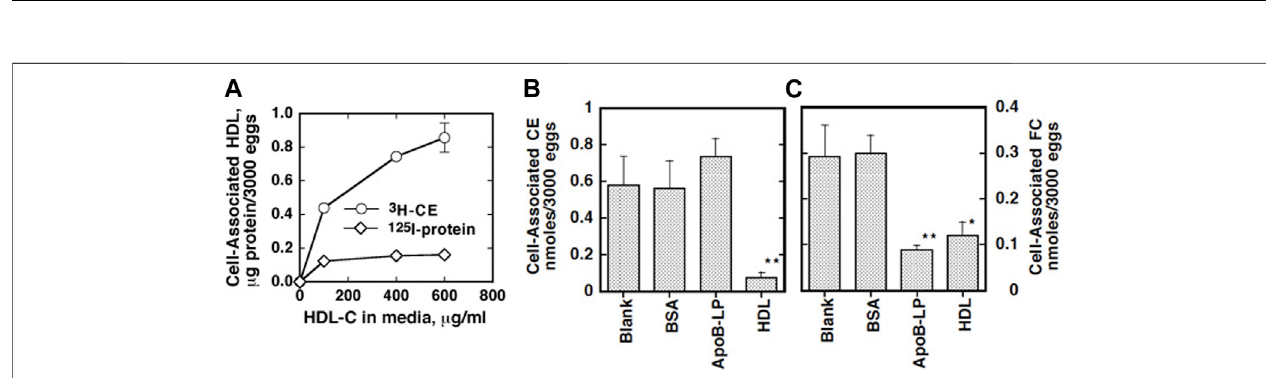
FIGURE 2 | Speci fi c cholesterol uptake from lipoproteins by S. japonicum eggs (Okumura-Noji et al., 2013). (A) Human HDL was labeled with [ 3 H]CE or 125 iodine. The S.japonicum eggswereincubated with[ 3 H]CE-HDLor 125 I-HDLat37and4 ° Cfor20 h.AssociationofHDLtheeggswasestimated asHDLprotein calculatedfrom eachspeci fi cactivity.Speci fi cassociationwasestimatedbydisplacementby10timesoftheamountofnon-labeledHDLanddifferencebetweentheresultsat37 ° Cand 4 ° C. (BandC) Selectiveuptakeofcholesterolby S.japonicum eggsfromHDL.HDLwasdouble-labeledwith[ 3 H]CEand[ 14 C]cholesterolandincubatedwiththe S. japonicum eggs in the presence of 10 times of excess of non-labeled HDL, non-labeled apoB lipoprotein (ApoB-Lp) or BSA (1 μ g/ml). Uptakes of CE (B) or cholesterol [FC, (C) ]werecalculatedasthedifferencebetweenthespeci fi cvaluesat37 ° Cand4 ° C.ThedatarepresenttheaverageandSEofthetriplicateassay.** p < 0.01and* p < 0.05 different from “ Blank ” .